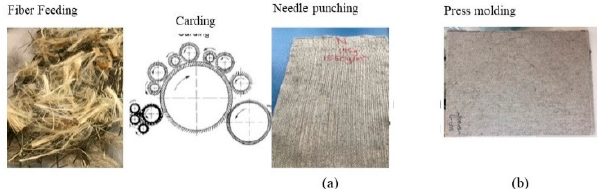
Figure 4. Schematic representation of composite manufacture by carding, needle punching, and subsequent compression molding ( a ) needled fiber mat, ( b ) laminate after hot pressing (modified illustration [84,94,95]).